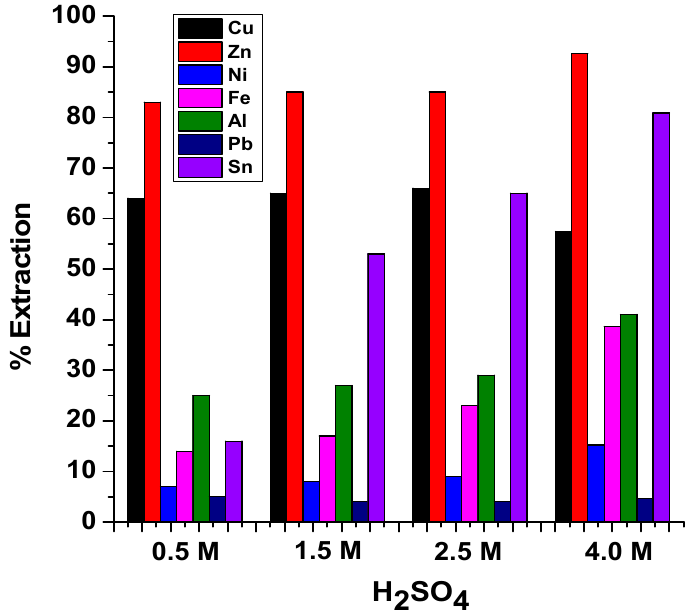
Figure 5. Comparative extraction efficiencies of Cu and Zn, and the co-extraction of other metals from WPCBs using H 2 SO 4 lixiviant, 50 g/L pulp density, 25 °C, 300 rpm, and 12 h.